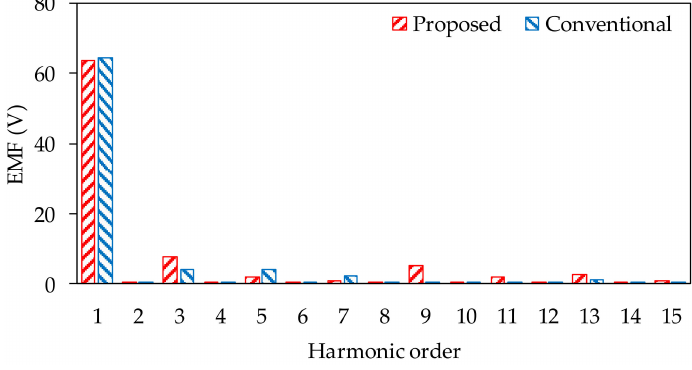
Figure 10. Spectra of the no-load back EMFs of the two compared